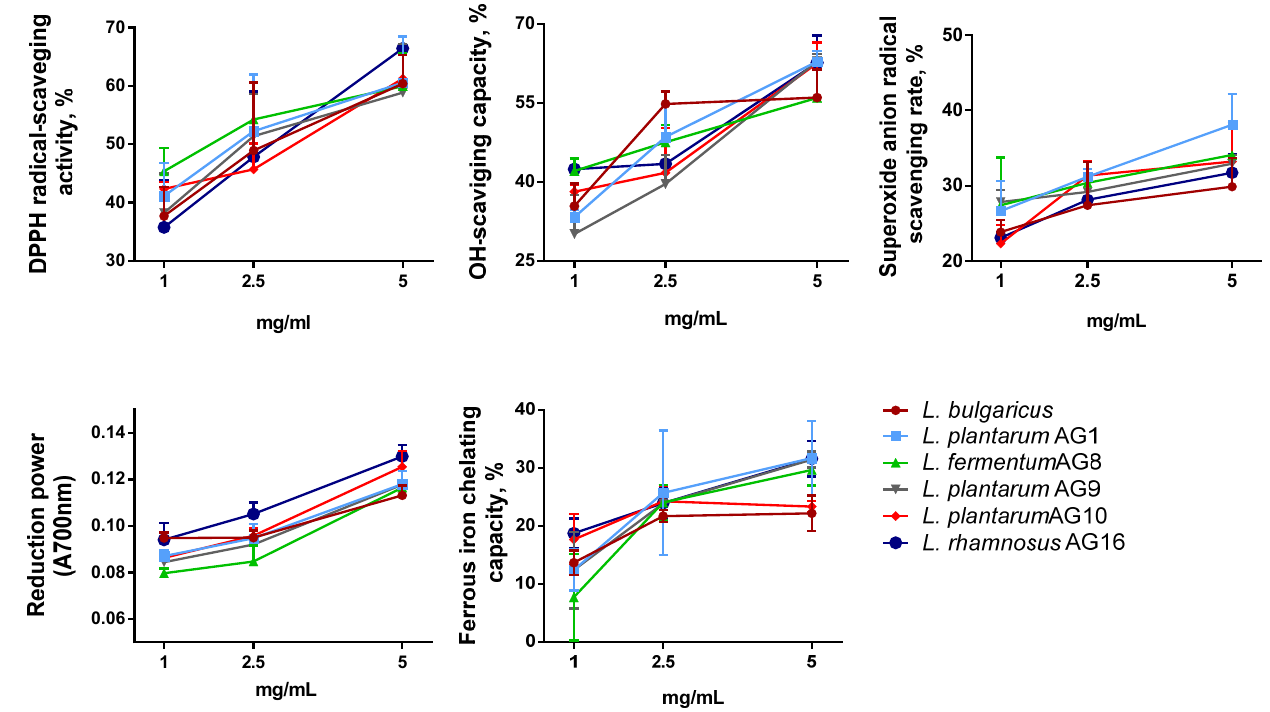
Figure 6. Antioxidant and chelating properties of EPS isolated from skim milk fermented by different strains of LAB.